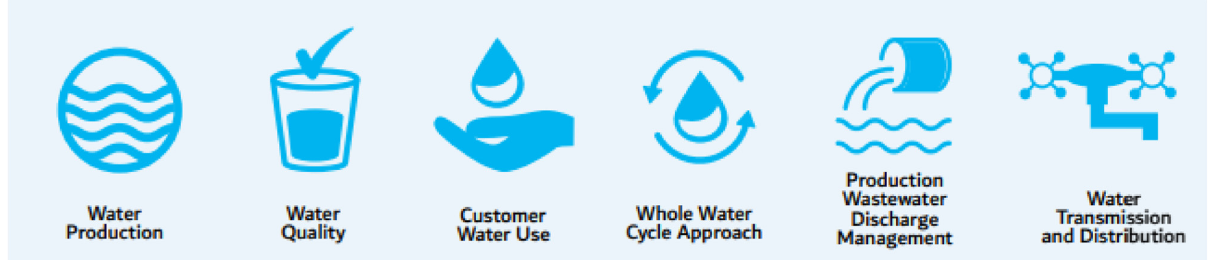
Fig. 3. Focus areas in water management approached by DEWA [2].